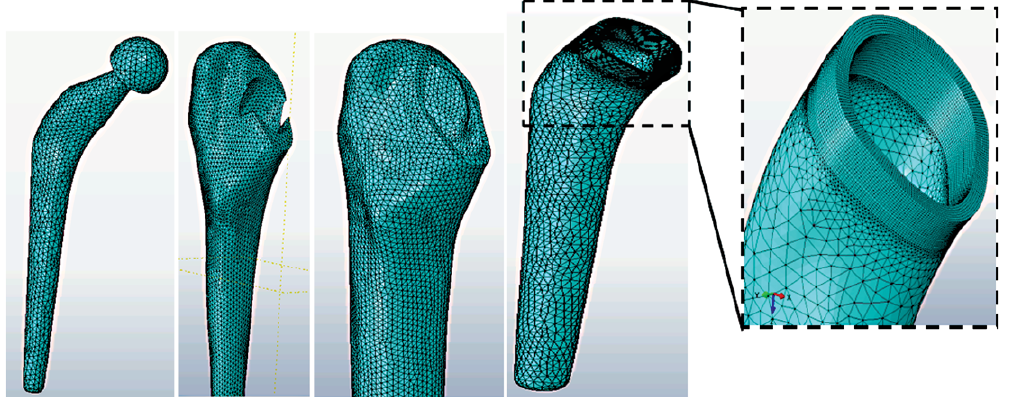
Fig. 7. (a) the crack rotation angle and (b) the opened crack within the submodel.